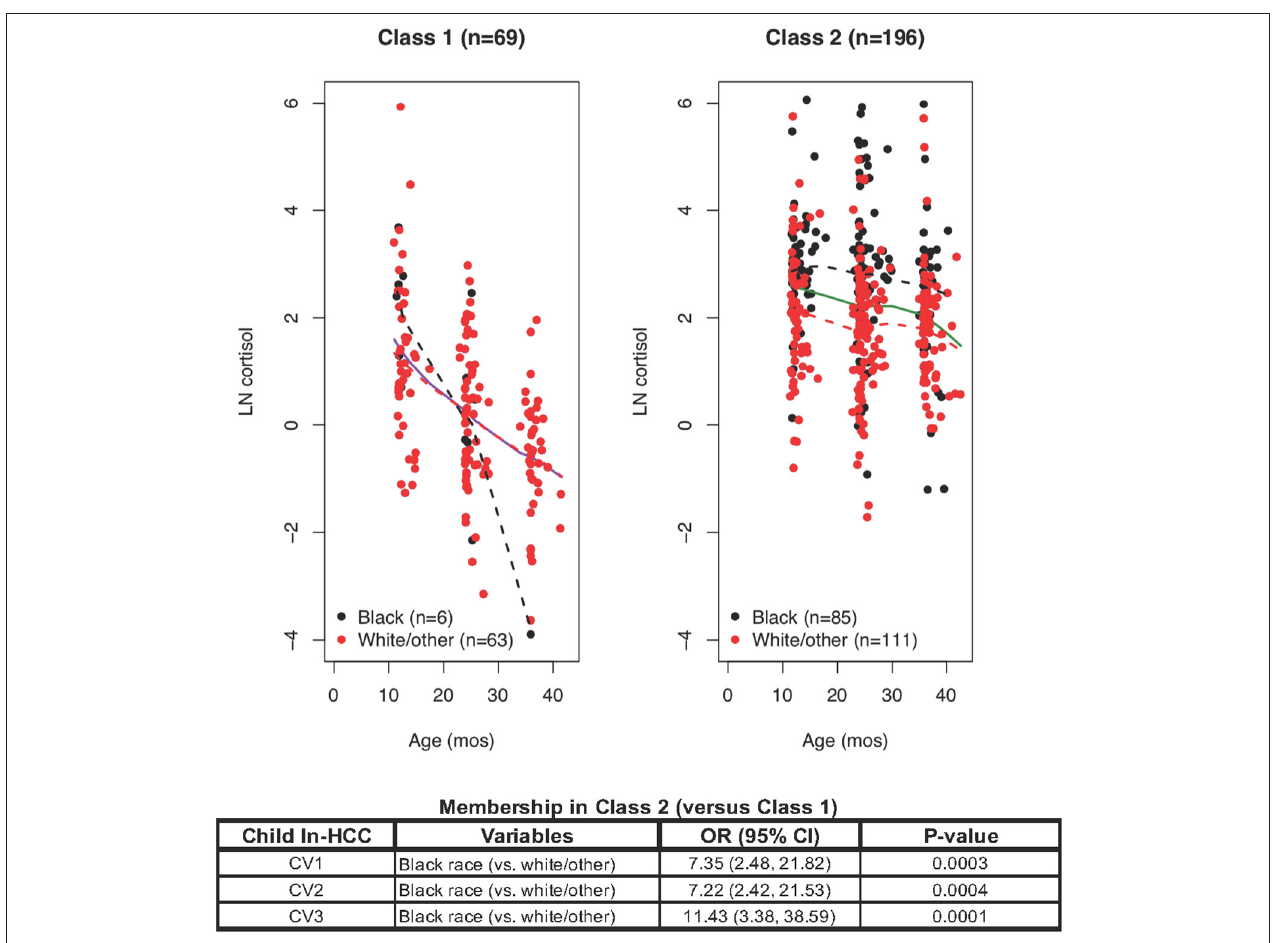
FIGURE 1 | Latent class mixed modeling (LCMM) revealed Class 1 and Class 2: ln-HCC values plotted by age in months, with solid regression lines for all children, dashed regression lines for Blacks (black) and White/other races (red). A logistic regression model revealed that Class 2 membership was determined by Black race at each clinic visit